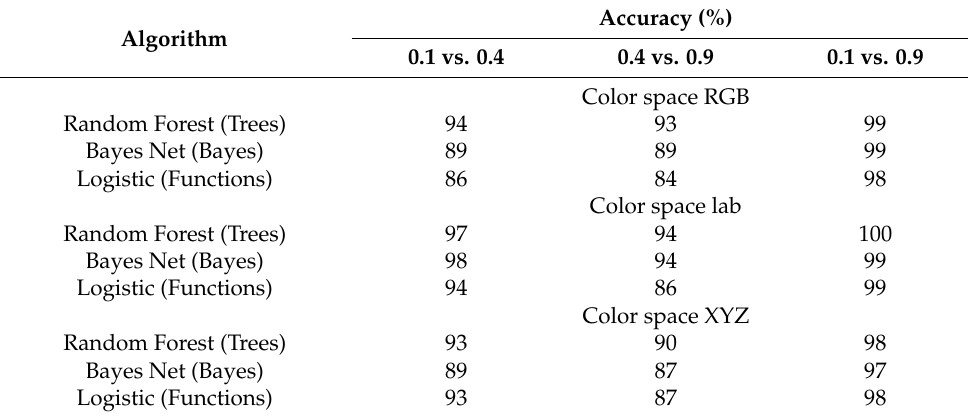
Table 3. The accuracy of distinguishing the ripening stages of peach ‘Redhaven’ based on sets of textures selected from individual color spaces of flesh images.